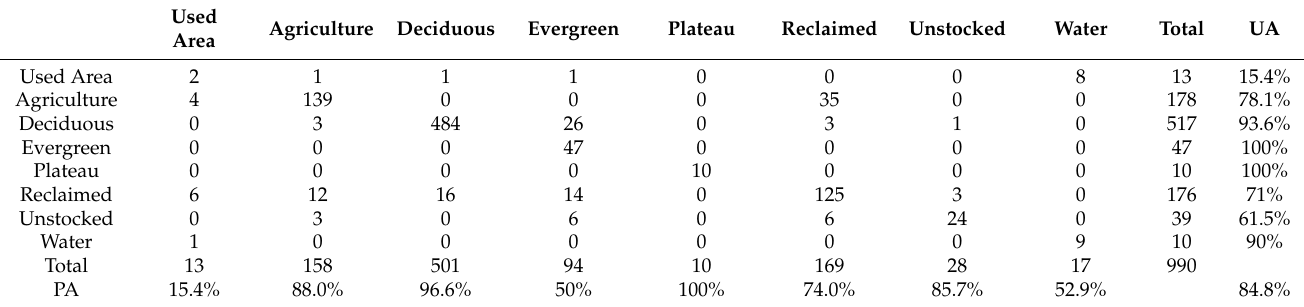
Table 1. Confusion matrix for the land cover classification of North Korea.